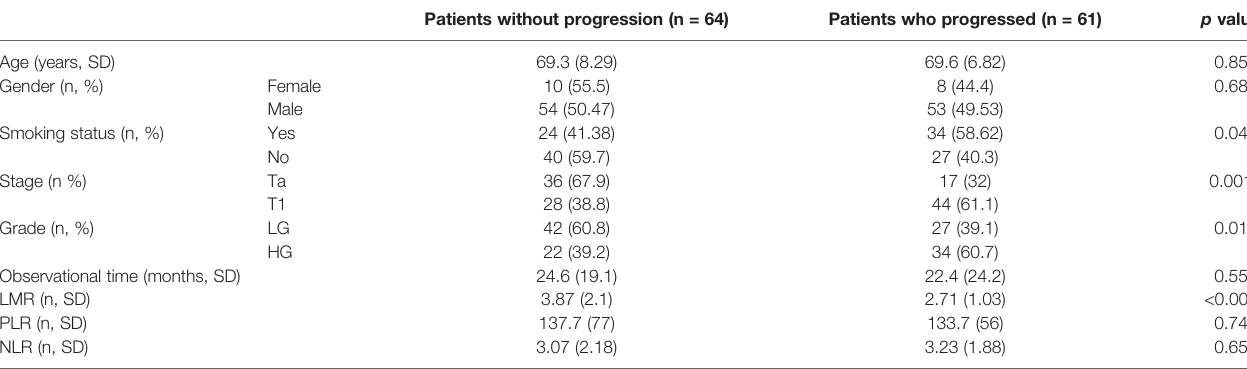
TABLE 1 | Demographic and clinical data of patients in analysis.